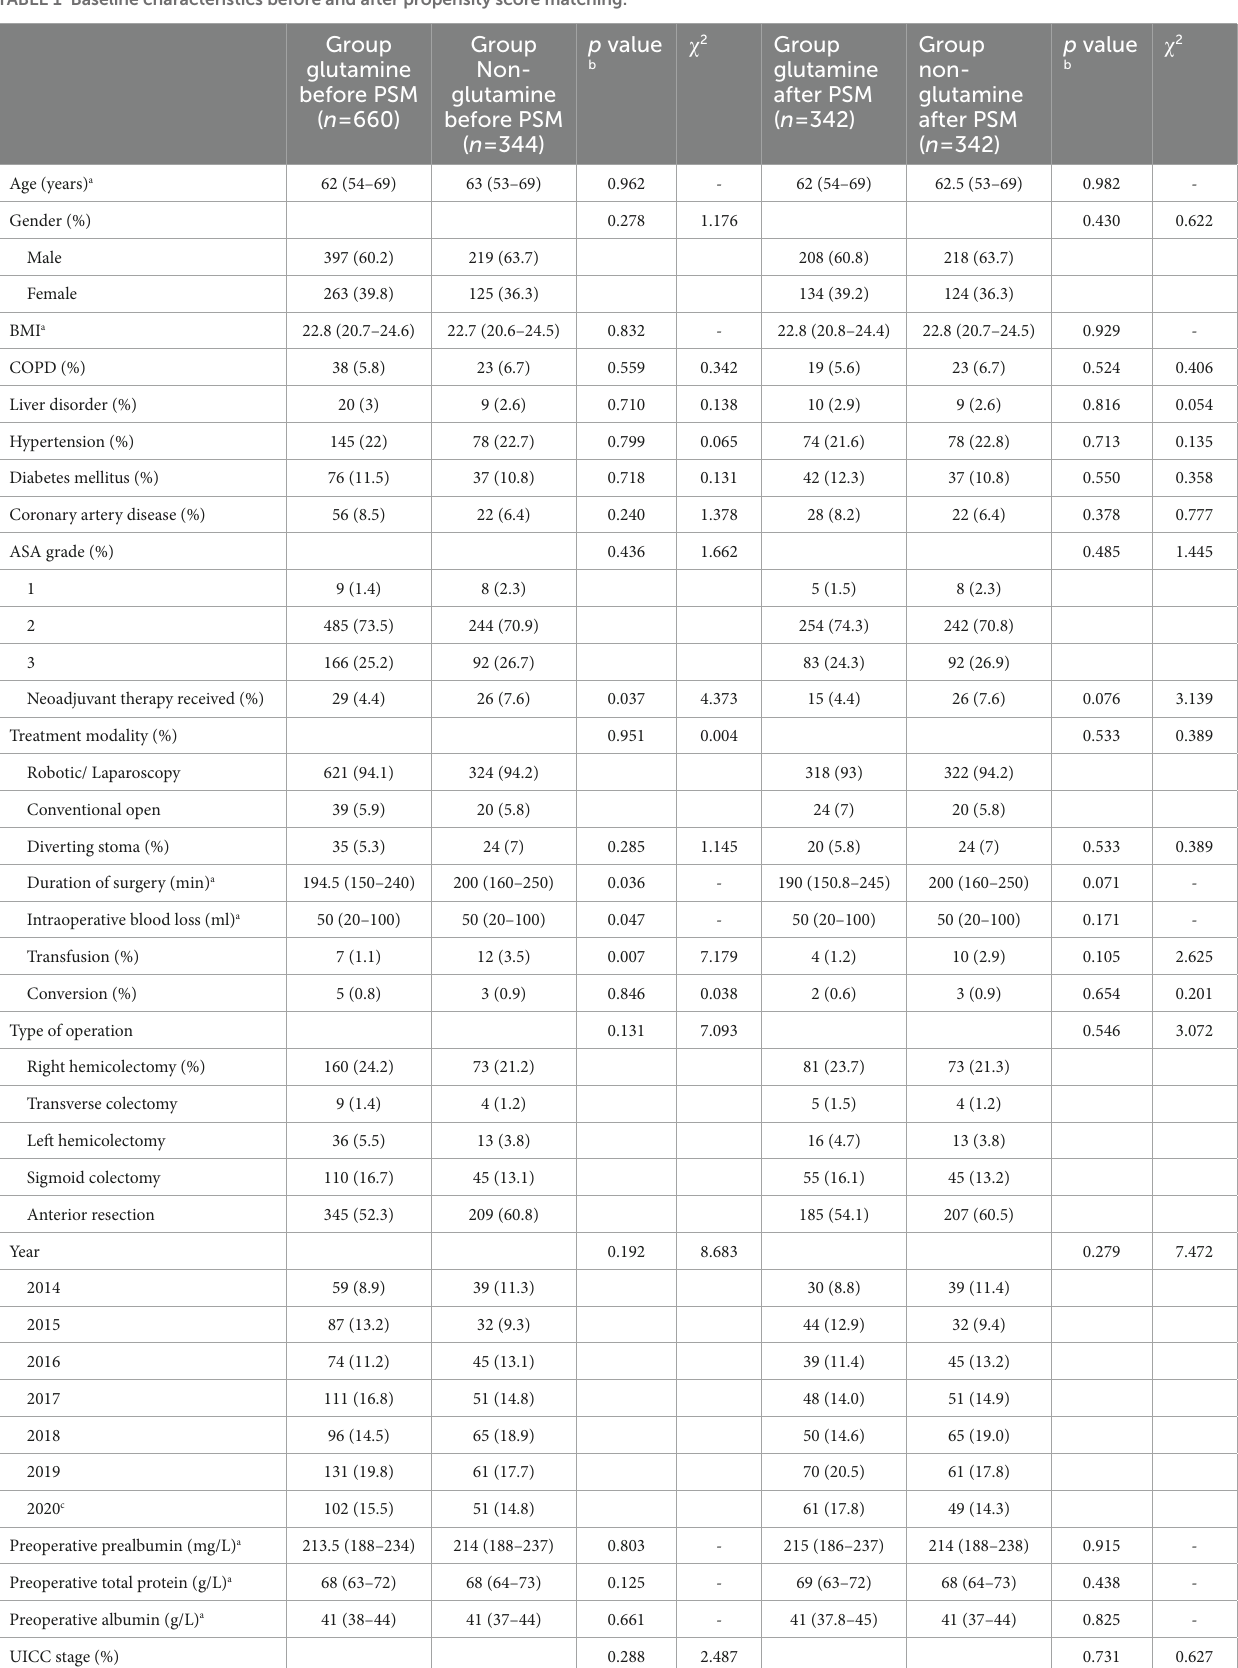
TABLE 1 Baseline characteristics before and after propensity score